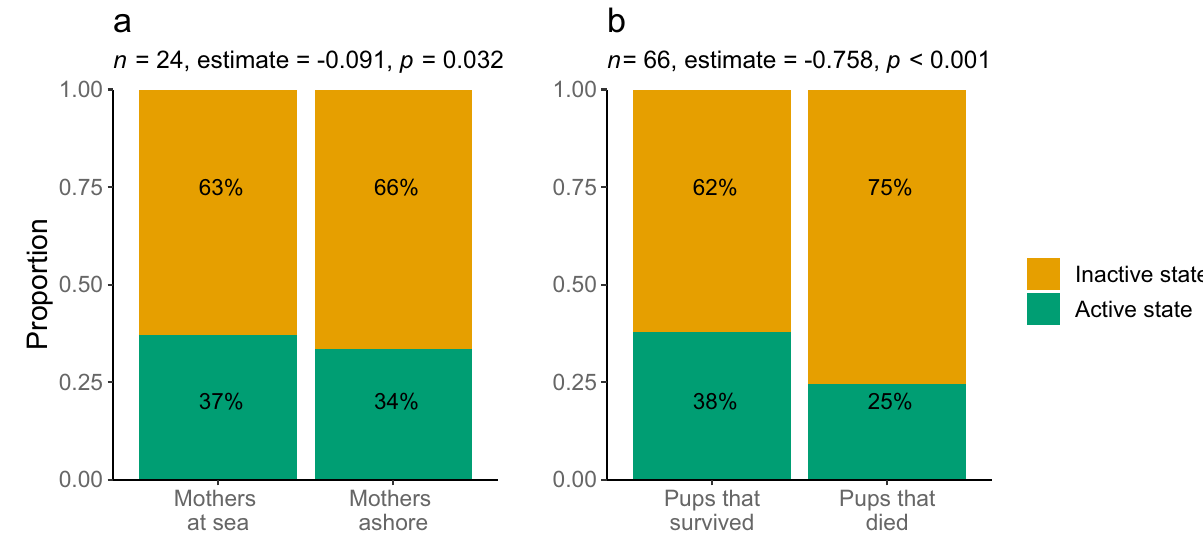
Figure 4. Results of post-hoc analyses. Proportion of time pups spent in the active and inactive states ( a ) when their mothers were at sea foraging or ashore nursing and ( b ) depending on mortality status. Sample sizes ( n ), GLMM slope estimates, and p -values are